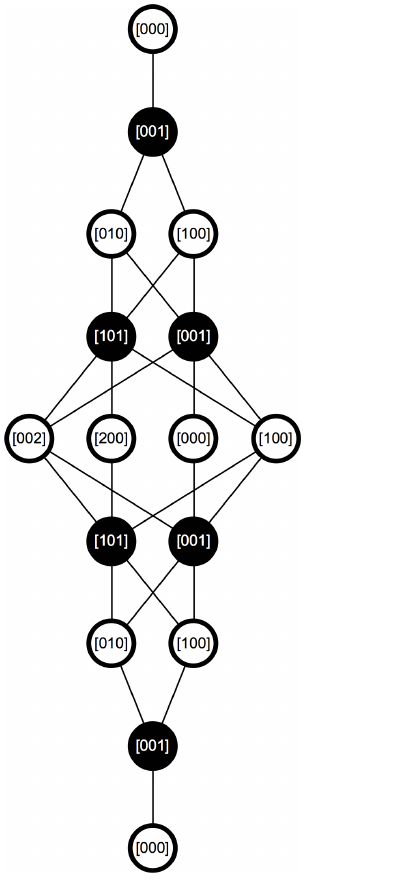
Figure 10 . Adinkra Diagram for 7D (1 , 0)